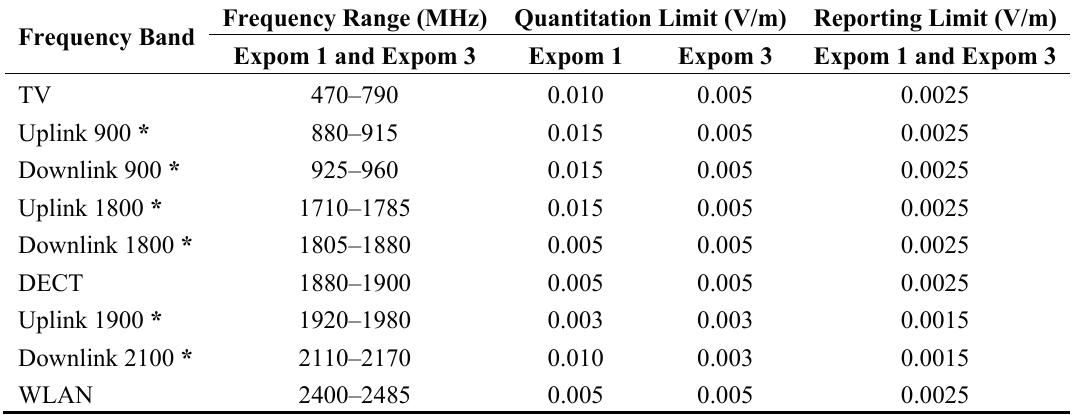
Table 1. Frequency range, quantitation limits and reporting limits for the frequency bands of the measurement devices Expom 1 and Expom 3 used for the personal